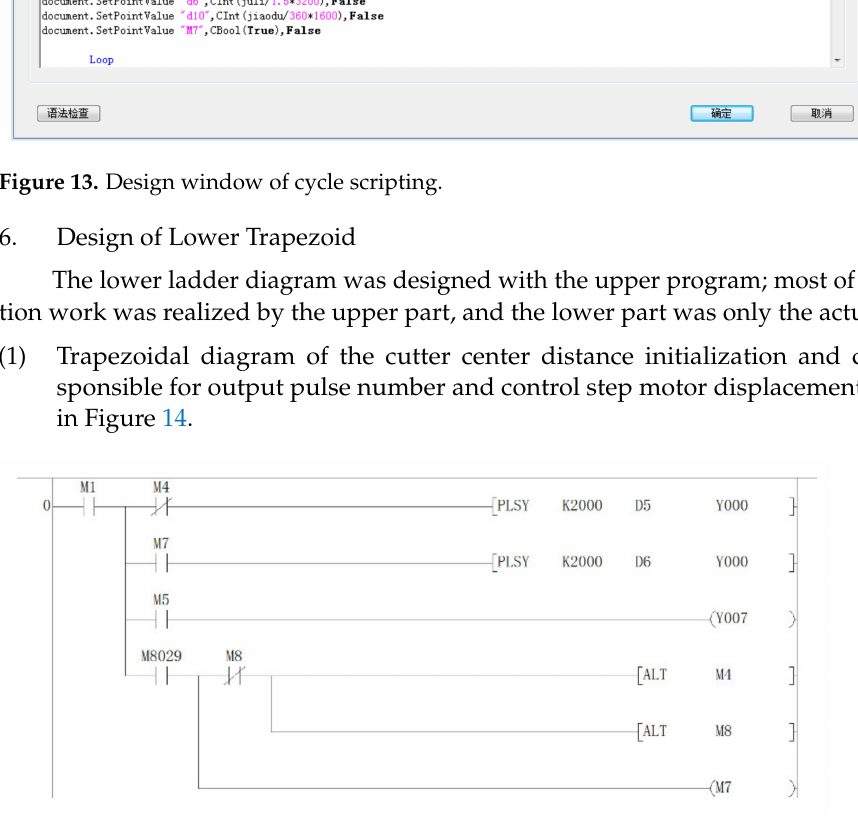
Figure 14. PLC program line diagram of initializing and changing center distance of the cutter. Trapezoidal diagram of cutter speed: responsible for monitoring speed and adjusting the duty cycle of the motor input pulse, so that the motor sets the speed, as shown in Figure